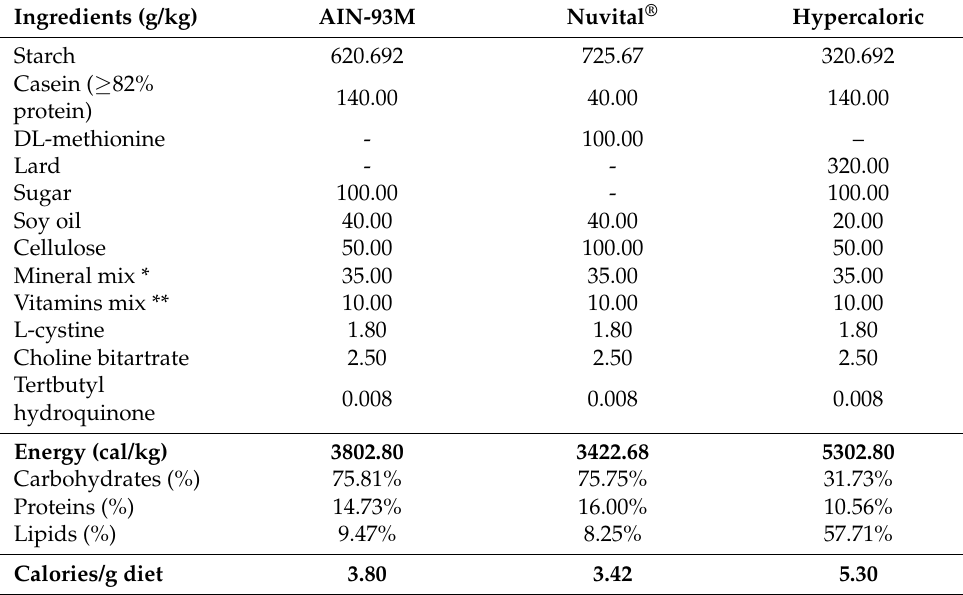
Table 5. Composition of experimental diets (g per kg of